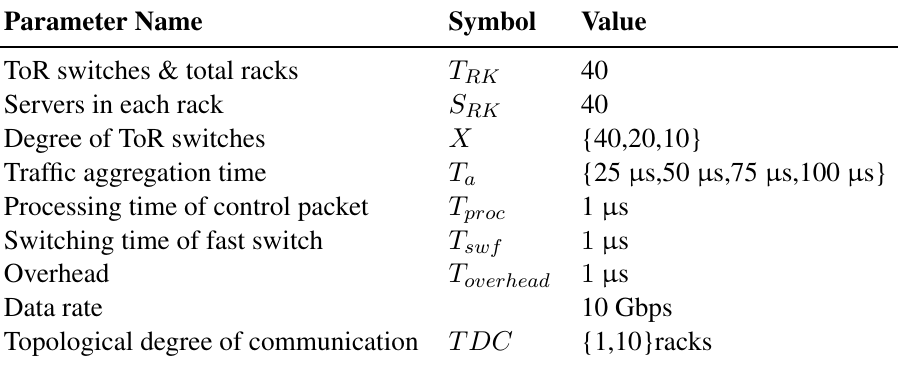
Table 1. Simulation